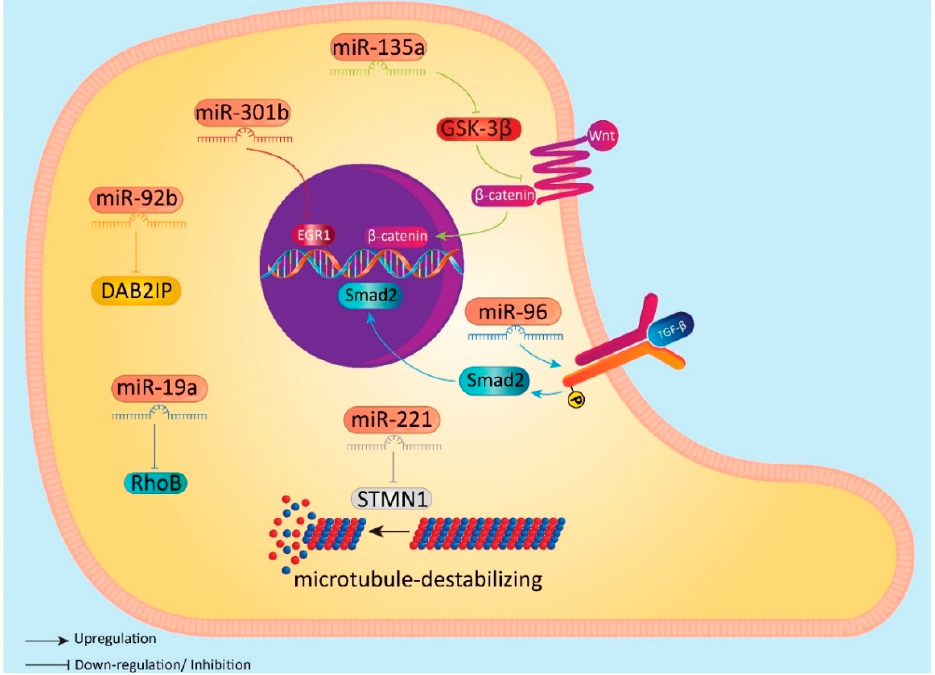
Figure 2. Induction of EMT by miRNAs in BC cells.